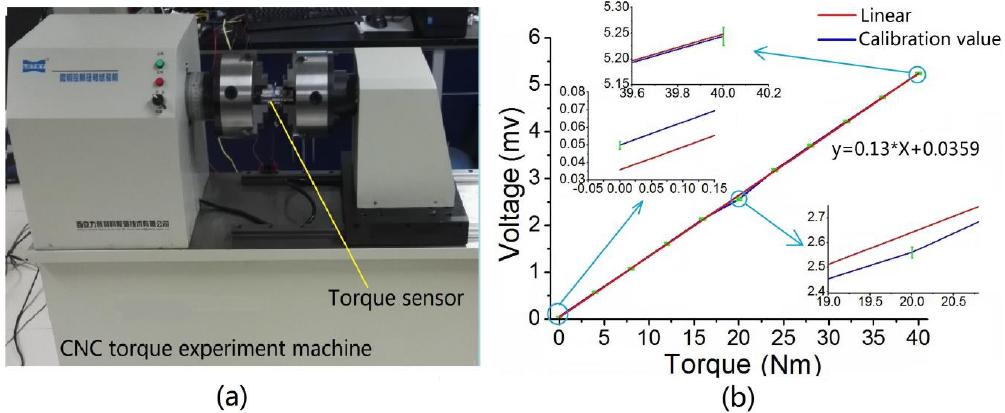
Figure 8. ( a ) Experimental setup for static calibration; ( b ) Calibration curve for the torque force.